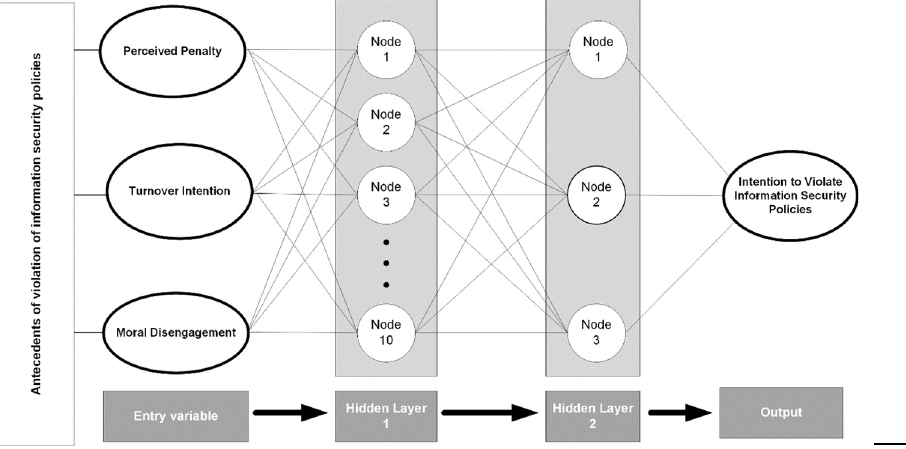
Figure 2. Neural network